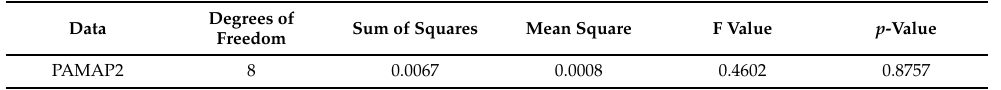
Table 9. ANOVA for PAMAP2 dataset.